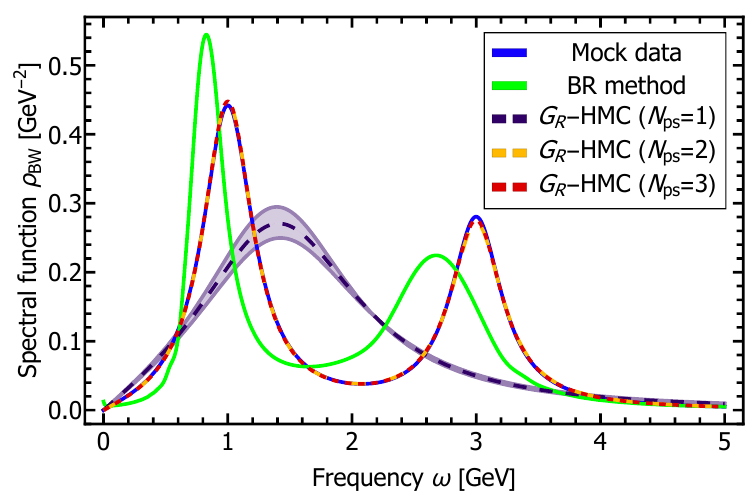
Figure 12: Reconstruction benchmark with a double Breit-Wigner